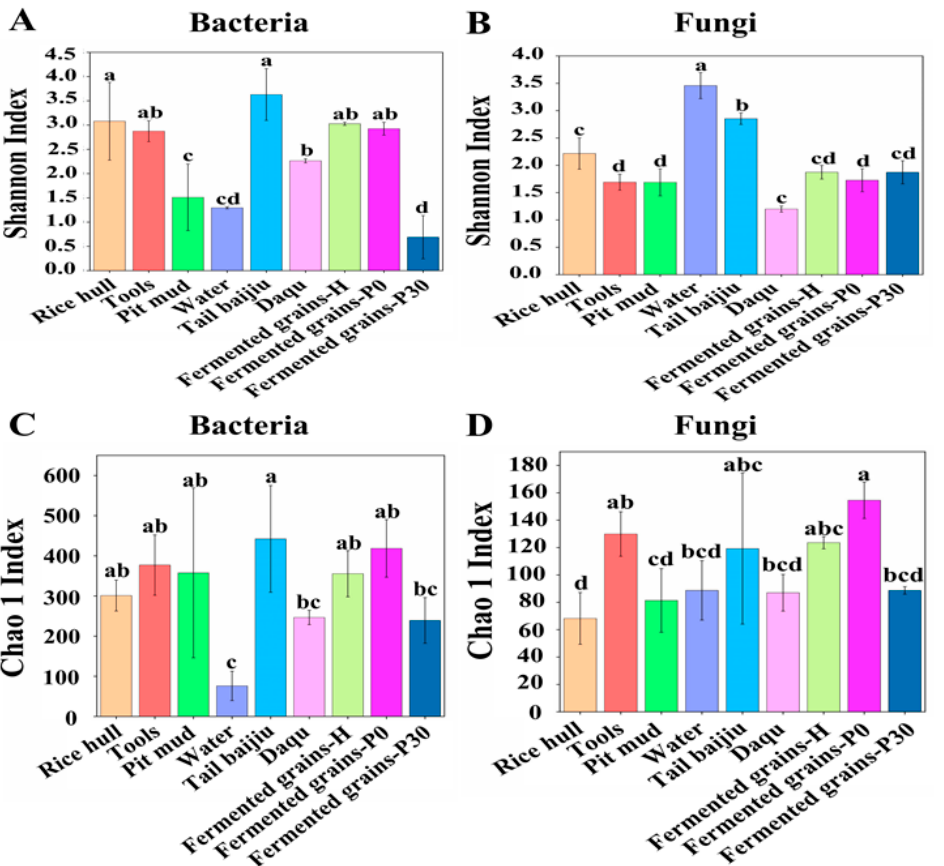
Figure 1. Alpha diversity of microbial community in Daqu, environment, and fermented grains during the heap and pit fermentation of Sauce-flavor Baijiu . Shannon index values of bacterial ( A ) and fungal communities ( B ). Chao 1 index values of bacterial ( C ) and fungal communities ( D ). a,b,c,d means in columns labeled with different letters differed significantly at p ﹤ 0.05.